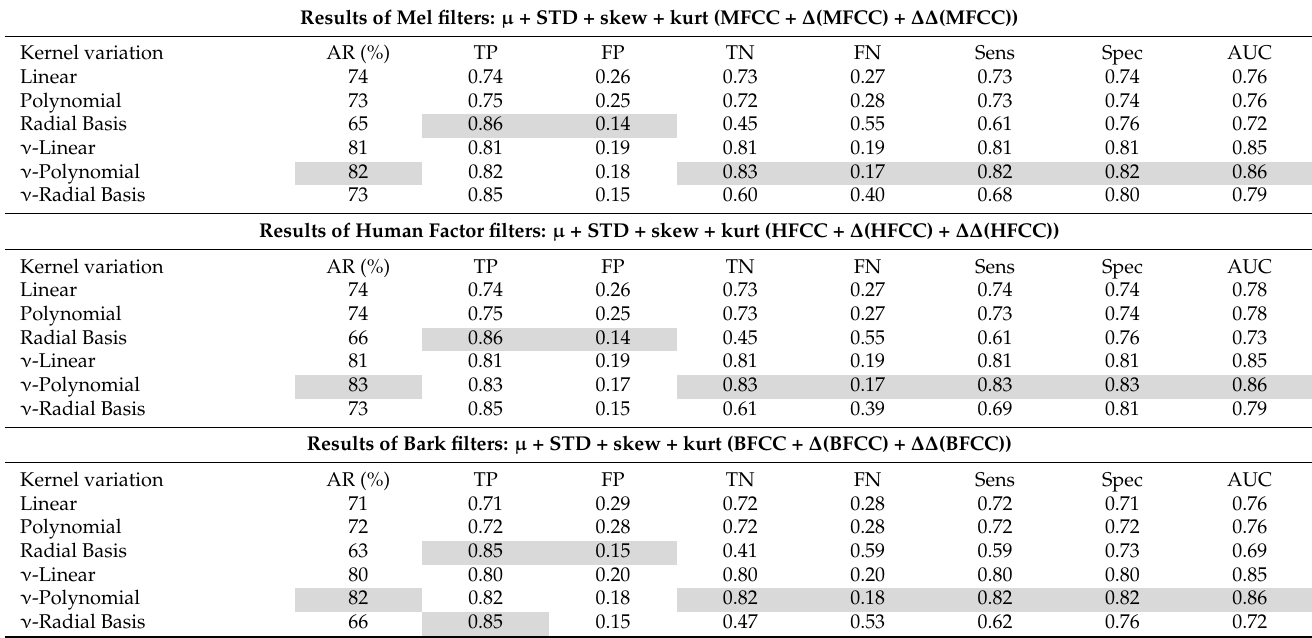
Table 5. Results of the variation of the kernel in the SVM model with MFCC, HFCC and BFCC filters, by employing the first four moments of their distributions (mean- µ , standard deviation-STD, skewness-skew and kurtosis-kurt). 10-cross-validation with 20,000 laughs (18,000 training and 2000 test in 10 epochs). AR, accuracy rate; TP, true positive; FP, false positive; TN, true negative; FN, false negative; Sens, sensitivity; Spec, specificity. Best performance per column is highlighted in